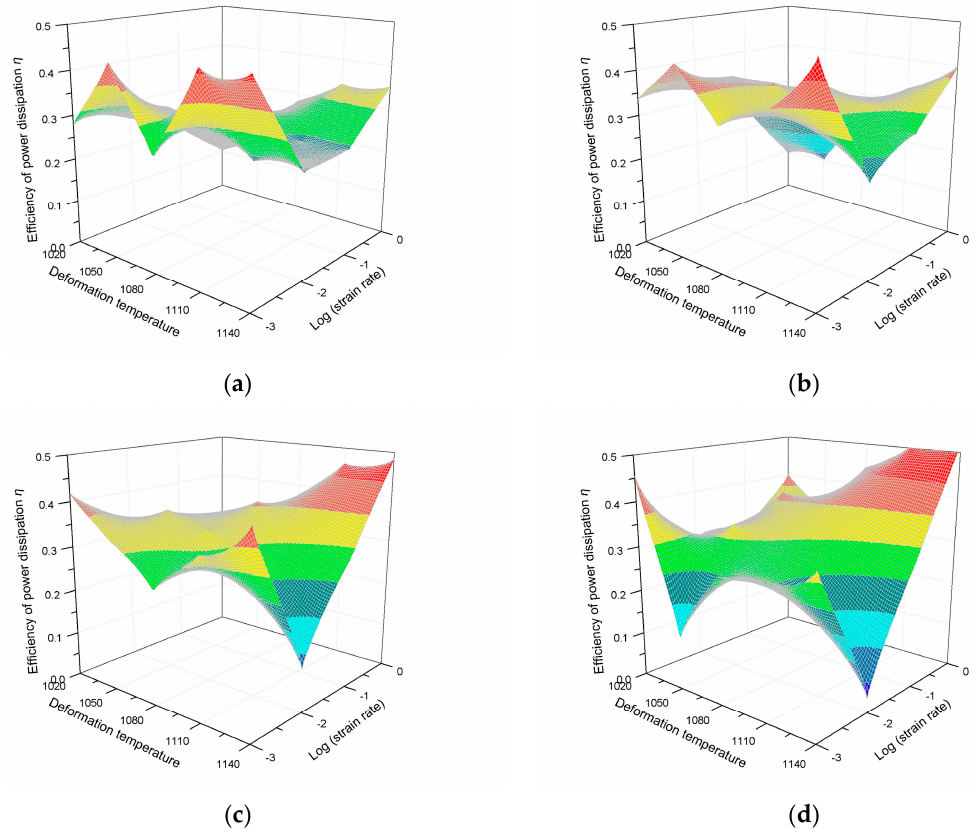
Figure 12. The response 3D surfaces of the efficiency of power dissipation ( η ) for the PM/Wrought dual superalloy to deformation temperature and strain rate as true strains: ( a ) 0.1; ( b ) 0.3; ( c ) 0.5; ( d ) 0.69.